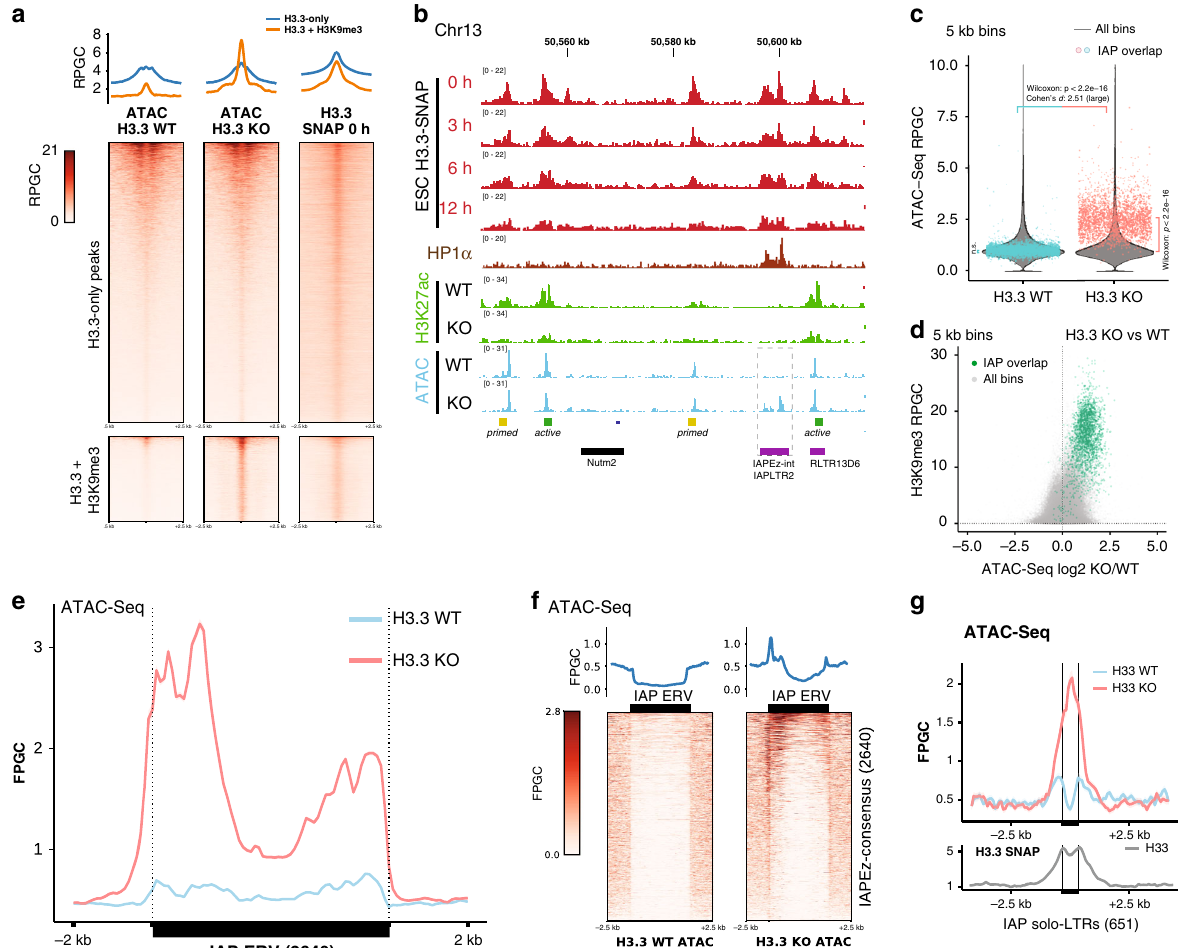
Fig. 3 Interstitial heterochromatin becomes accessible in the absence of H3.3. a Read density heatmaps and average pro fi les of H3.3-SNAP time-ChIP 9 and ATAC-Seq 20 over two classes of H3.3 peaks, H3.3-only and H3.3 + H3K9me3 peaks. See Supplementary Figs. 7 and 8 for additional analysis. b Genome tracks showing H3.3-SNAP time-ChIP 9 , H3K27ac 20 , and ATAC-Seq 20 signal over example region on Chr13. All tracks are normalized to Reads Per Genomic Content (RPGC). Source data are provided as a Source Data fi le. c Violin plots showing genome-wide distribution of ATAC-Seq signal in 5 kb bins, in H3.3 wildtype (WT) and knockout (KO) cell lines. Overlayed in color are 2797 individual bins overlapping with 2640 shared IAP ERVs. Two-sided Wilcoxon rank test ( p < 2.2e-16) and large Cohen ’ s effect size ( d = 2.51 ± 0.07) show signi fi cant increase in accessibility for IAP ERV containing bins in H3.3 KO. Genome-wide comparison between H3.3 WT and KO shows a signi fi cant ( p = 6.4e-14) difference but negligible effect size ( d = 9.4e-6). IAP- overlapping bins are not different from genome-wide average in H3.3 WT ( p = 0.97), but signi fi cantly different ( p < 2.2e-16) in H3.3 KO. Data shown from n = 1 biological replicate. Source data are provided as a Source data fi le. d Scatter plot of 5 kb bins, showing H3K9me3 level versus log2-fold change in ATAC-Seq signal upon H3.3 knockout. Bins overlapping with IAP ERVs are drawn in green. e Average coverage of ATAC-Seq signal over 2640 shared IAP ERVs in H3.3 wildtype (WT) and knockout (KO) cell lines. Fragments de fi ned by paired-end reads were piled up and normalized to 1x Genome coverage (Fragments Per Genomic Content, FPGC). f Density heatmaps and average pro fi les of ATAC-Seq signal using only uniquely mappable reads, over 2640 shared IAP ERVs and fl anking regions. See Supplementary Fig. 7e for quantitative analysis and Supplementary Fig. 9 for further comparison with H3.3 and H3K9me3 ChIP pro fi les. g Average coverage (FPGC) of ATAC-Seq signal (top) and H3.3-SNAP ChIP using only uniquely mappable reads, over 651 IAP solo LTRs (mostly IAPLTR2). Source data are provided as a Source data fi